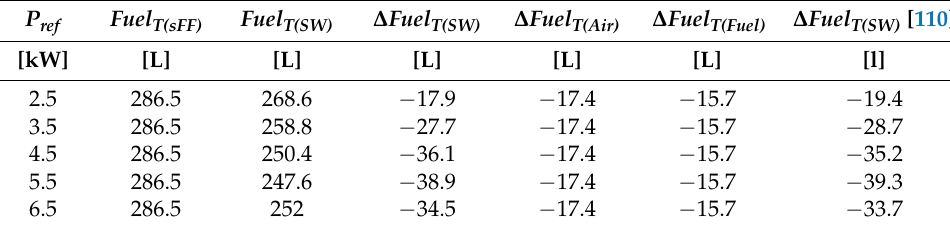
Table 6. Fuel economy for the third load profile (symmetrical stair up and